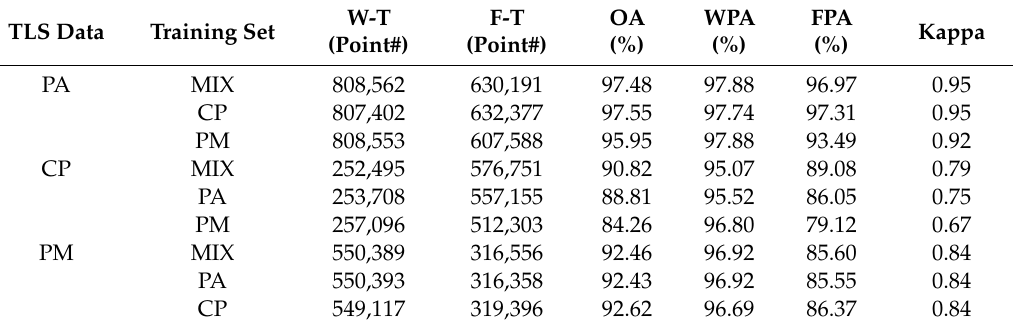
Table 4. The classification accuracy of using a training point set selected from one plot (PA, CP or PM) or mixed training point sets (MIX) to train the FWCNN model to separate woody and foliage points from the LRI-corrected TLS data. The F-T and W-T mean the number of foliage and woody points that were correctly classified within the test sets. The OA means the overall classification